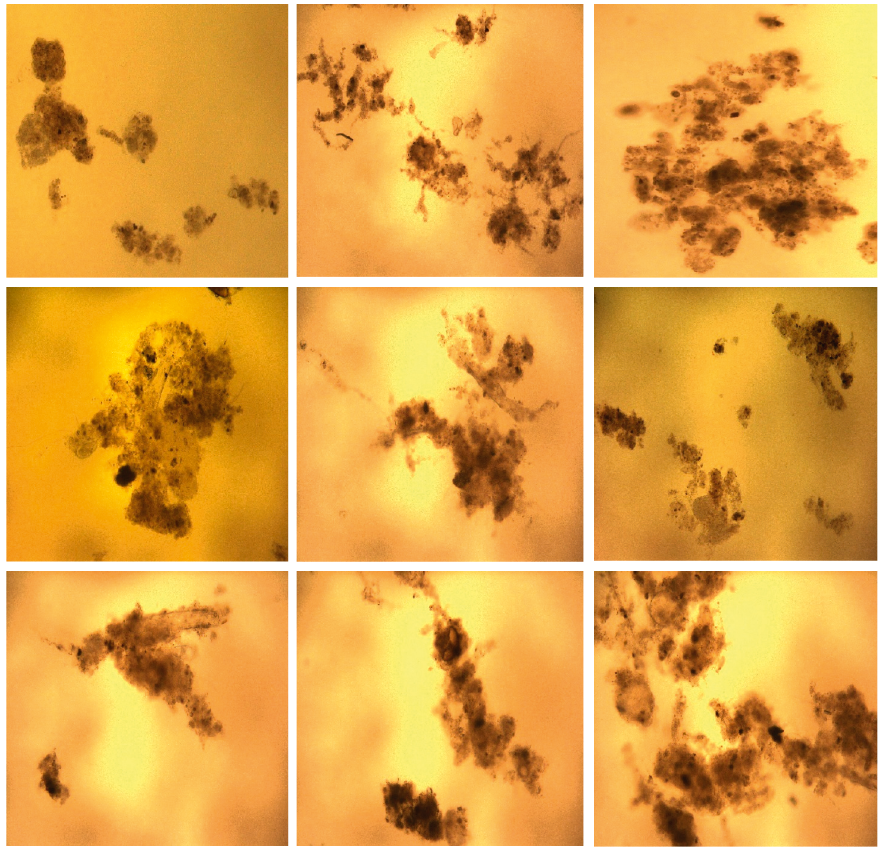
Figure 3: Gallery of some samples microscopic images of activated